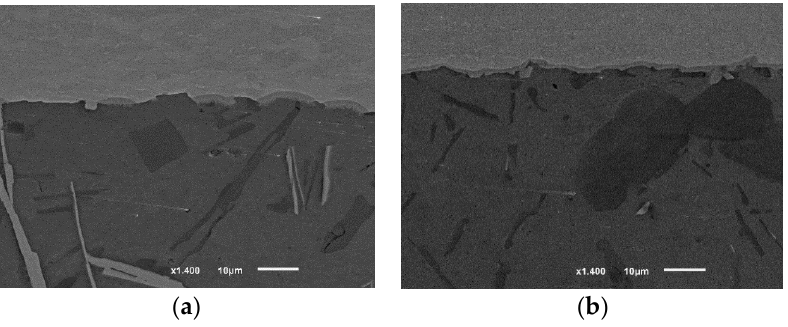
Figure 12. SEM images (SEI) of brazed joints using Al-13Si filler alloy at 585 °C (close to the middle of the joint) where: ( a ) Joint brazed with USV only, “No initial load” (13/585U); ( b ) Joint brazed with initial load only “No USV” (13/585L).